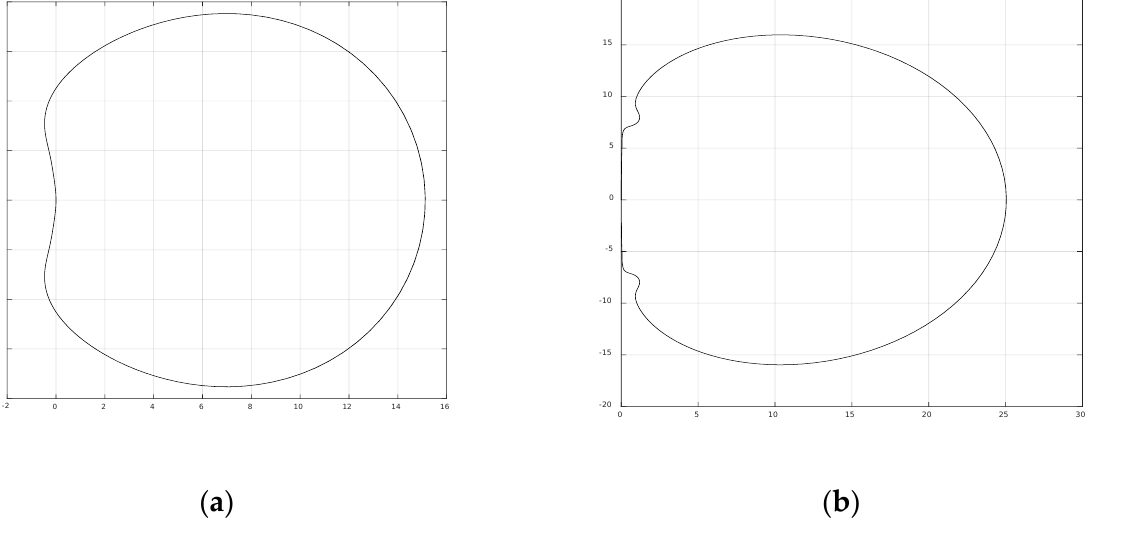
Figure 2. Regions of absolute stability of the block hybrid methods. ( a ) Method (18) is A( α )-stable . ( b ) Method (21) is A -stable.